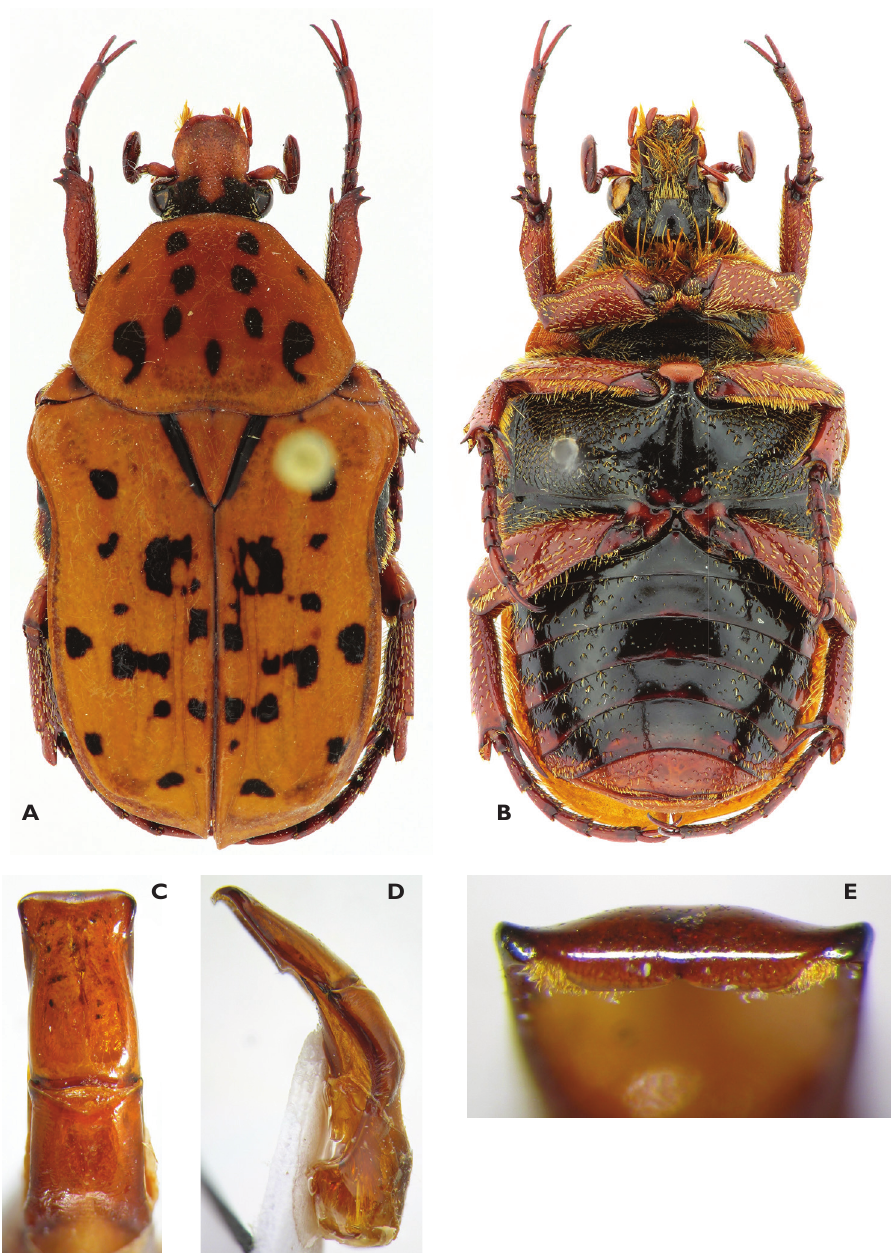
Figure 4. Atrichelaphinis ( Atrichelaphinis ) nigropunctulata (Péringuey, 1896) male, South Africa, Barberton (PCSR). A Dorsal view B ventral view C parameres in dorsal view D parameres in lateral view E apex of the